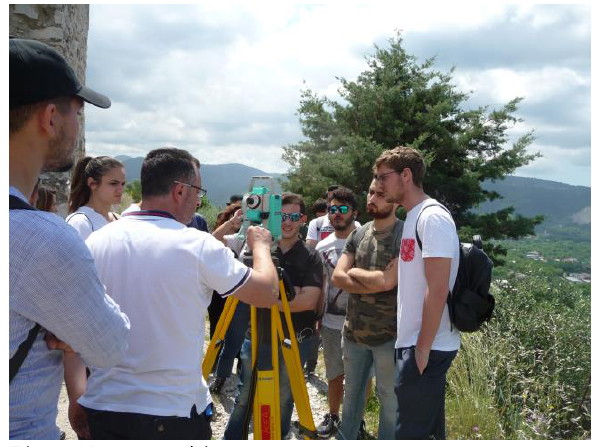
Figure 10: topographic